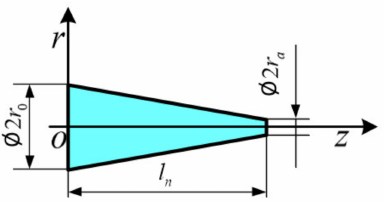
Figure 2. The structure parameters of the conical